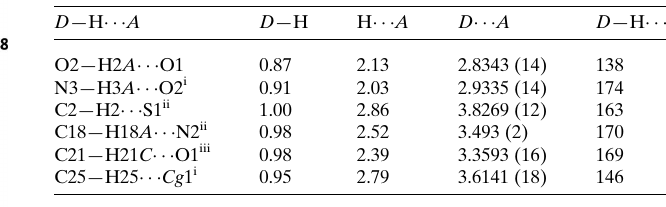
Table 1 Hydrogen-bond geometry (A˚ , (cid:4) ).